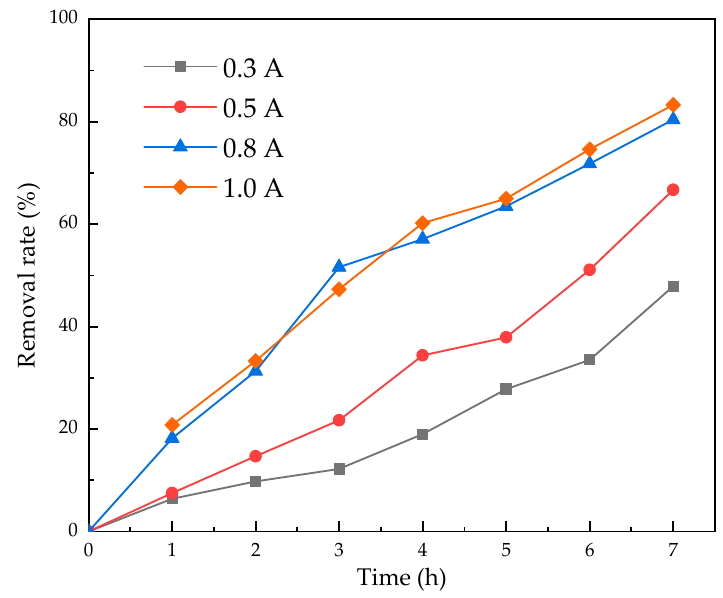
Figure 6. Effect of current intensity on the electrolysis of nicosulfuron.